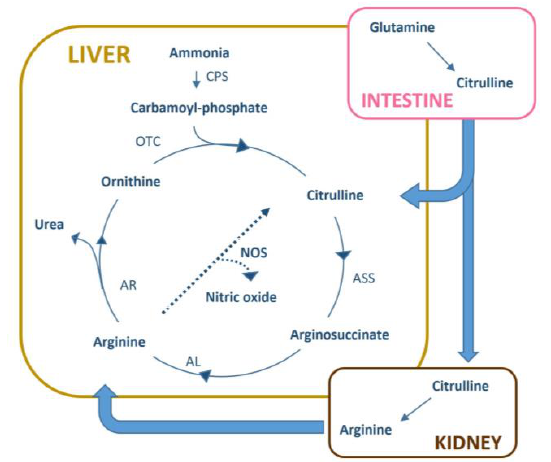
Figure 4. Metabolic pathways involving citrulline and arginine. Abbreviation: CPS, carbamoyl phosphate synthetase; ASS, argininosuccinate synthase; AL, argininosuccinate lyase; AR, arginase; OTC, ornithine transcarbamoylase.